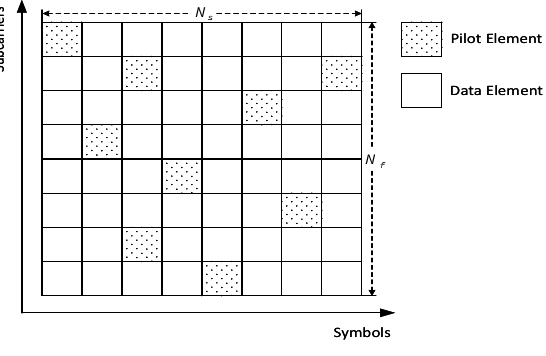
Figure 1. The structure of an OFDM